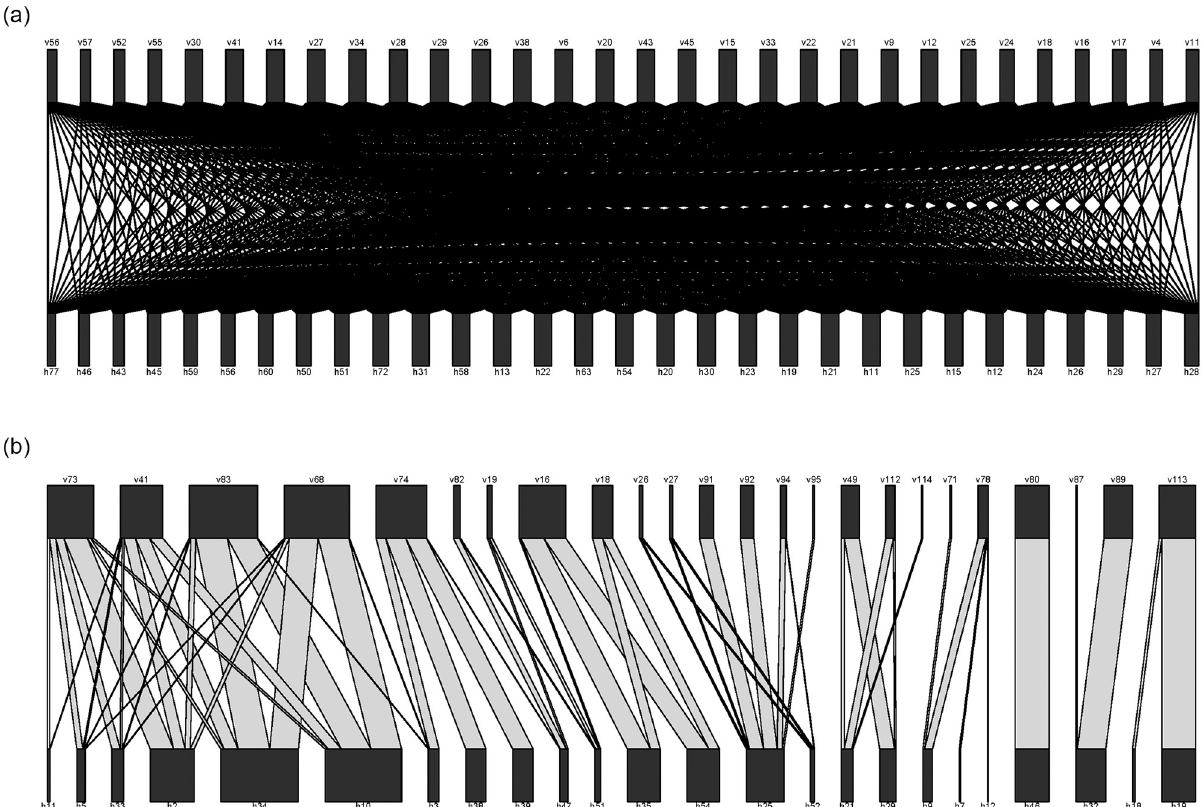
Fig 2. Bipartite networks for representative simulations with small and large values of host specificity (g). Width of bar reflects overall summed preference by vectors (top, taxa labeled starting with v) for hosts (bottom, taxa labelled starting with h), and plots show all preference scores between vectors and hosts that are 0.01 or greater (maximum value is always 1). The smallest version of g used was 0.021 (top plot), revealing generalist vectors. The largest value of g was 4.98, with more vectors specializing on only a few